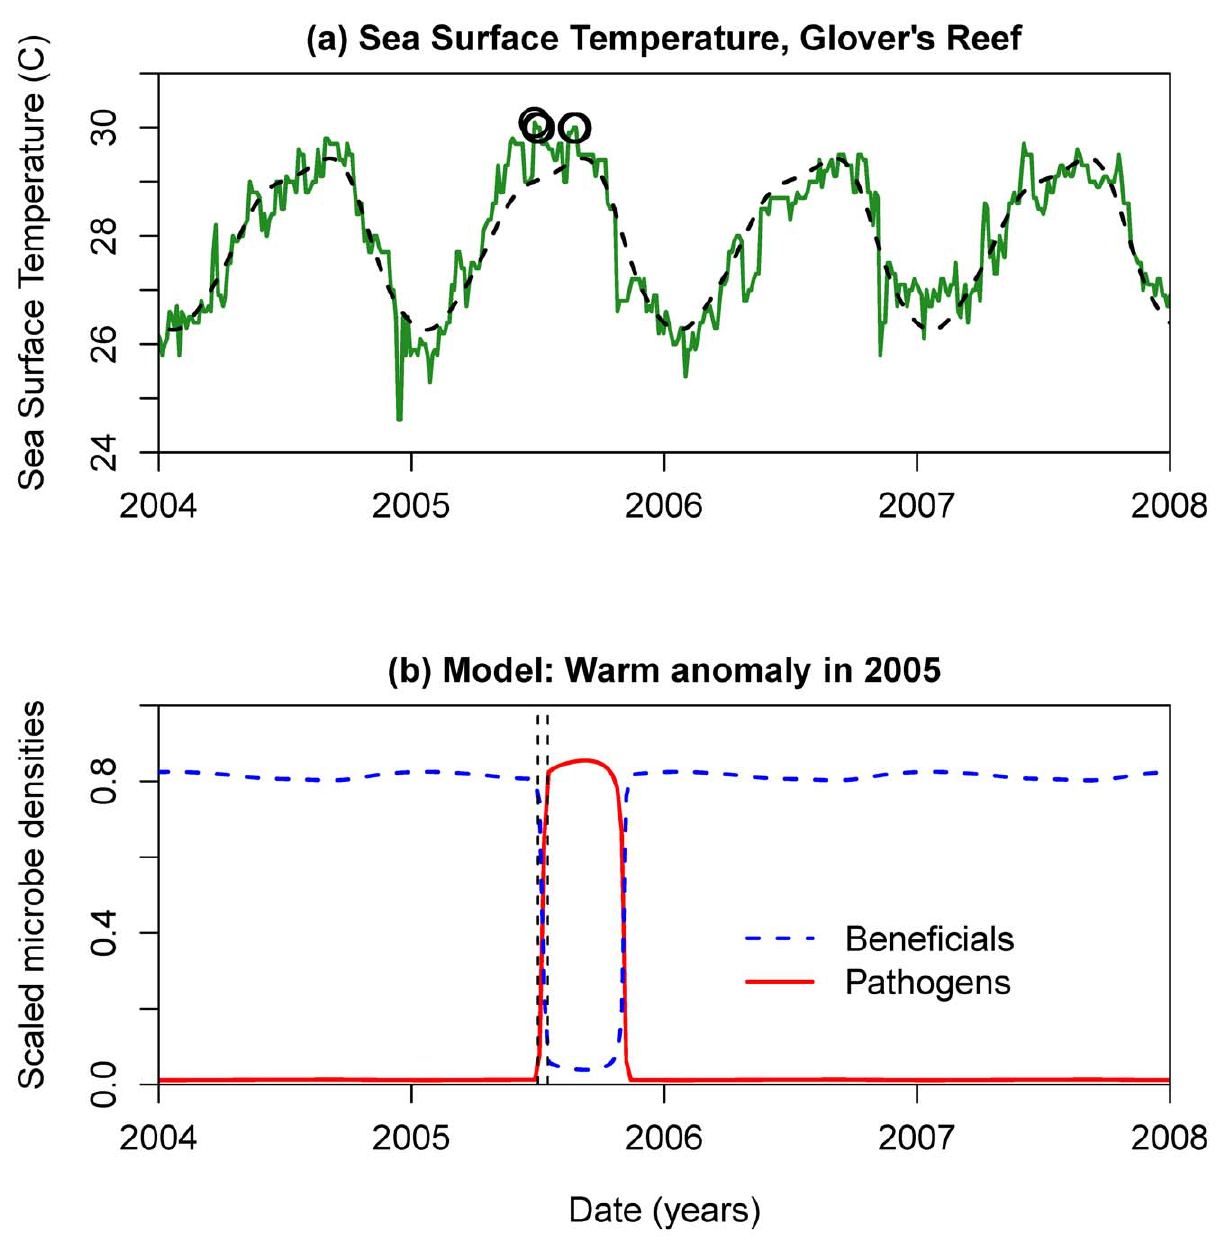
Figure 3. Effects of a brief thermal anomaly on microbial population dynamics in the well-mixed SMC model. (A) NOAA sea surface temperature record for Glover’s Reef, Belize (from coralreefwatch.noaa.gov/satellite/data_nrt/timeseries/all_Glovers.txt). The open circles show temperatures considered high enough to elevate the risk of coral bleaching; the dashed curve is the fitted seasonal trend (a periodic smoothing spline) used to simulate the model (B). Simulations of the model using the seasonal temperature trend plotted in panel (A), but with a 2-wk thermal anomaly (indicated by the vertical dashed lines) during which temperature was elevated by 1 degree C, and antibiotic activity by beneficials was eliminated.